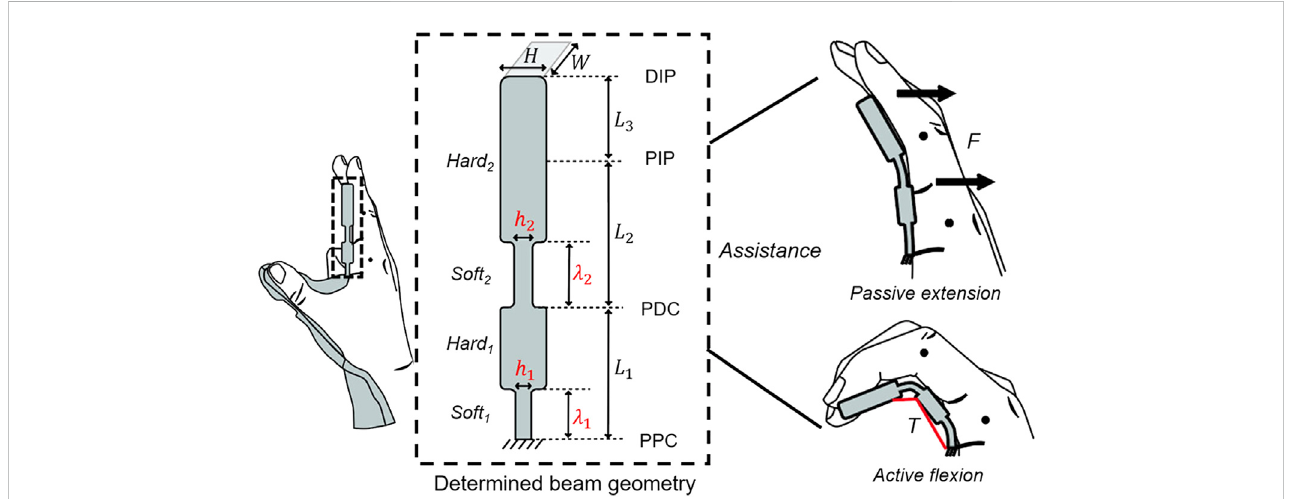
FIGURE 4 Determined beam geometry consisting of two soft regions ( Soft 1 and Soft 2 ) and hard regions ( Hard 1 and Hard 2 ) under the geometric constraints. The stiffness of the soft regions is determined by the design variables ( h 1 , h 2 , λ 1 , λ 2 ) calculated via stiffness optimization. The other variables are set when the anthropometric dimensions of individual hands are